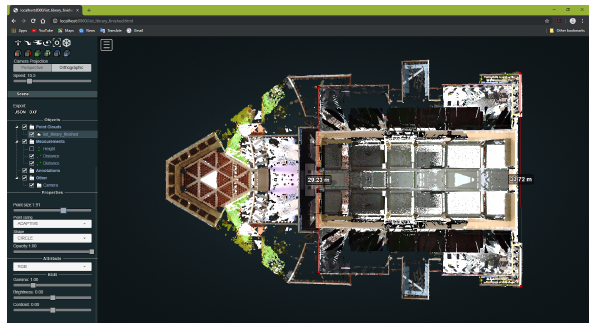
Figure 6. Top view of the library.